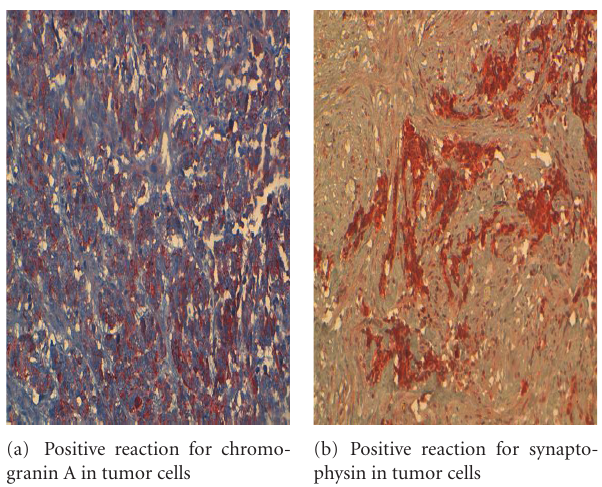
Figure 7: CT-scan-guided TCB slide of a pancreatic mass in a 56-year-old man. Immunohistochemical features at higher magnification view: positive reaction for chromogranin A and synaptophysin in tumor cells.